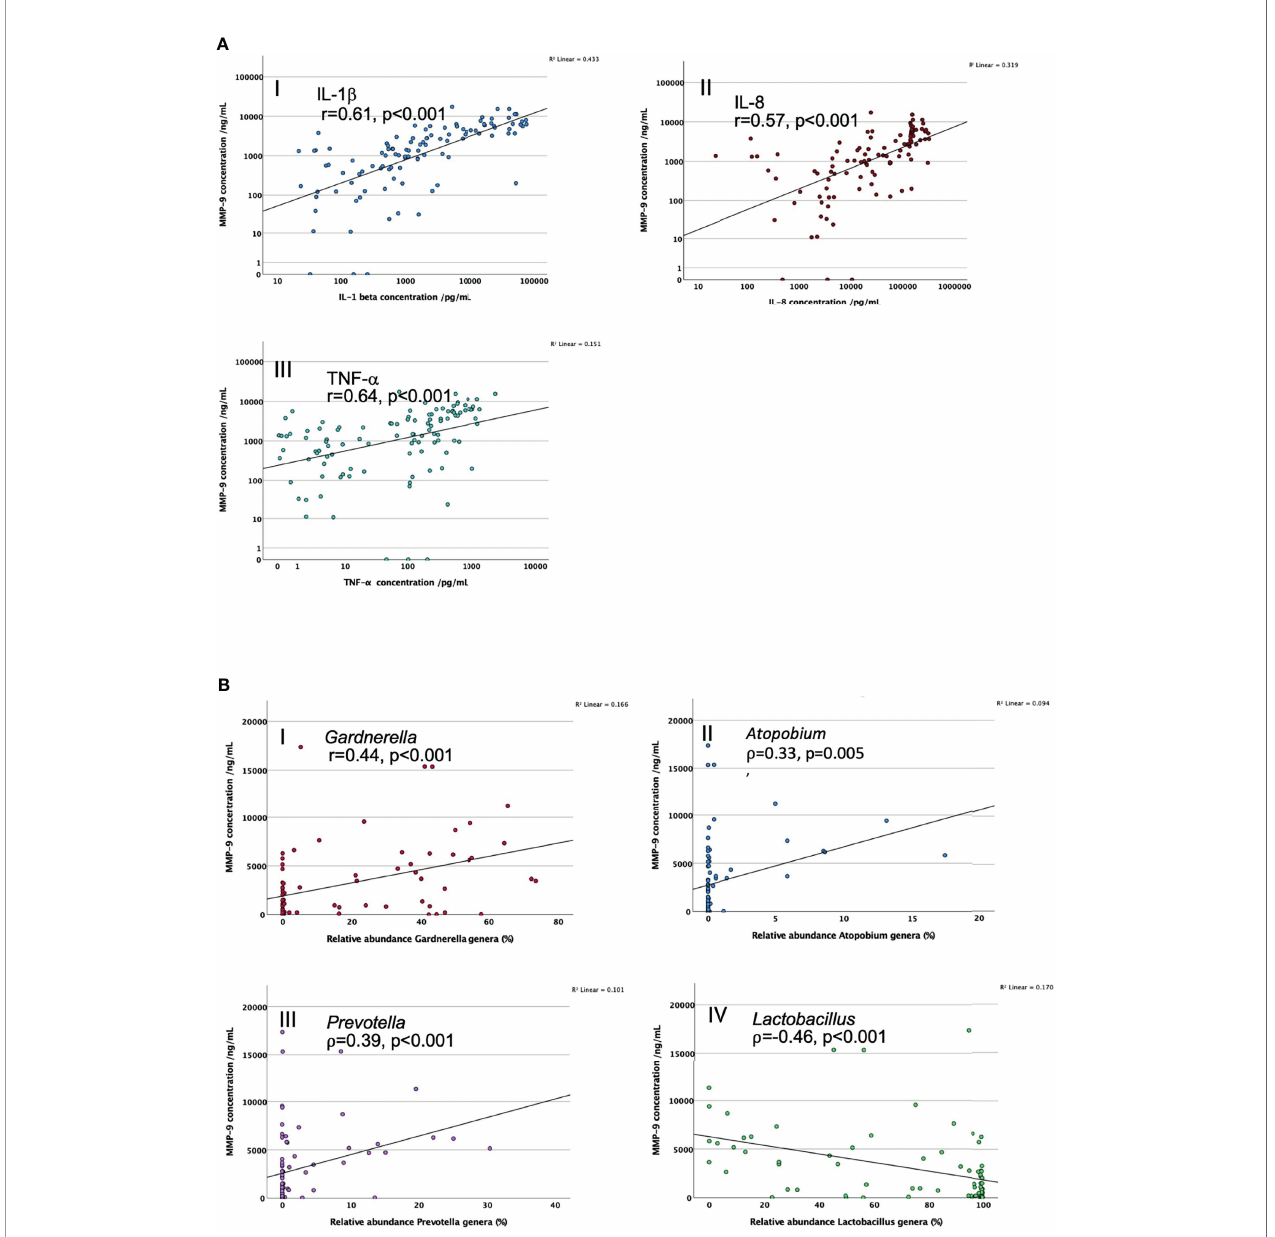
FIGURE 2 | (A) Scatter graphs to explore correlation of CVF MMP-9 concentrations with key CVF cytokine concentrations. I. IL-1 b ; II. IL-8; III. TNF- a . (B) Scatter graphs to explore correlation of CVF MMP-9 concentrations with proportions of key vaginal bacterial genera. I. Gardnerella; II . Atopobium; III. Prevotella; IV. Lactobacillus. r = correlation co-ef fi cient, controlled for maternal age, BMI and